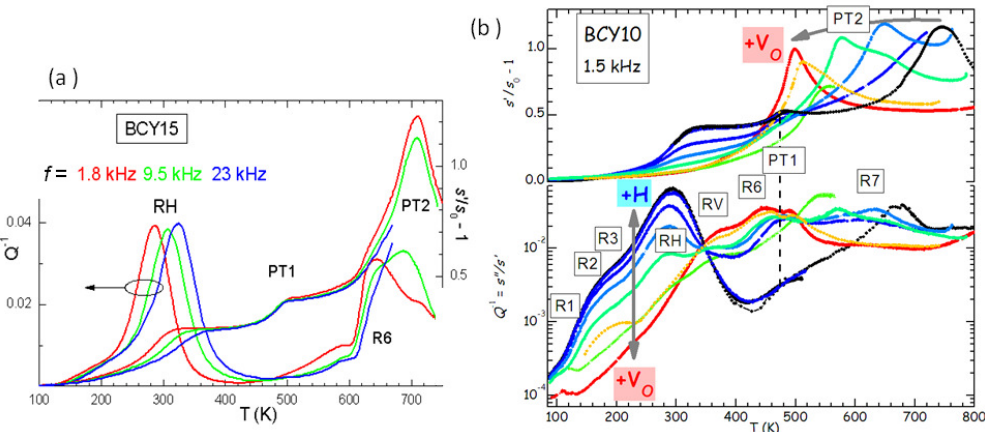
Figure 5. ( a ) Elastic energy loss and compliance s (cid:48) normalized to its value s 0 at 0 K of hydrated BaCe 1 − x Y x O 3 with x = 0.15, measured during the same run at three frequencies; ( b ) Elastic energy loss and normalized compliance of BaCe 1 − x Y x O 3 with x = 0.10 at different levels of hydration and outgassing. The thermally activated relaxation processes are labelled as R x , while the phase transitions with PT x . The arrows indicate the sequence according to increasing hydration (+H) or outgassing (+V O